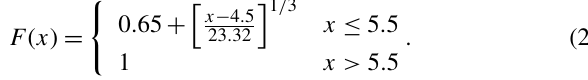
Figure 7. Optimally tuned parameters for the Larsen wake model: (a) C t and (b) x 0 as a function of the hub-height velocity, U ∗ each lidar cluster, while the lines are colored by the incoming-turbulence intensity (legend at the top left corner); (c) Prandtl’s mixing-length parameter, c 1 , versus incoming-turbulence intensity and colored by U ∗ fitting between c 1 and